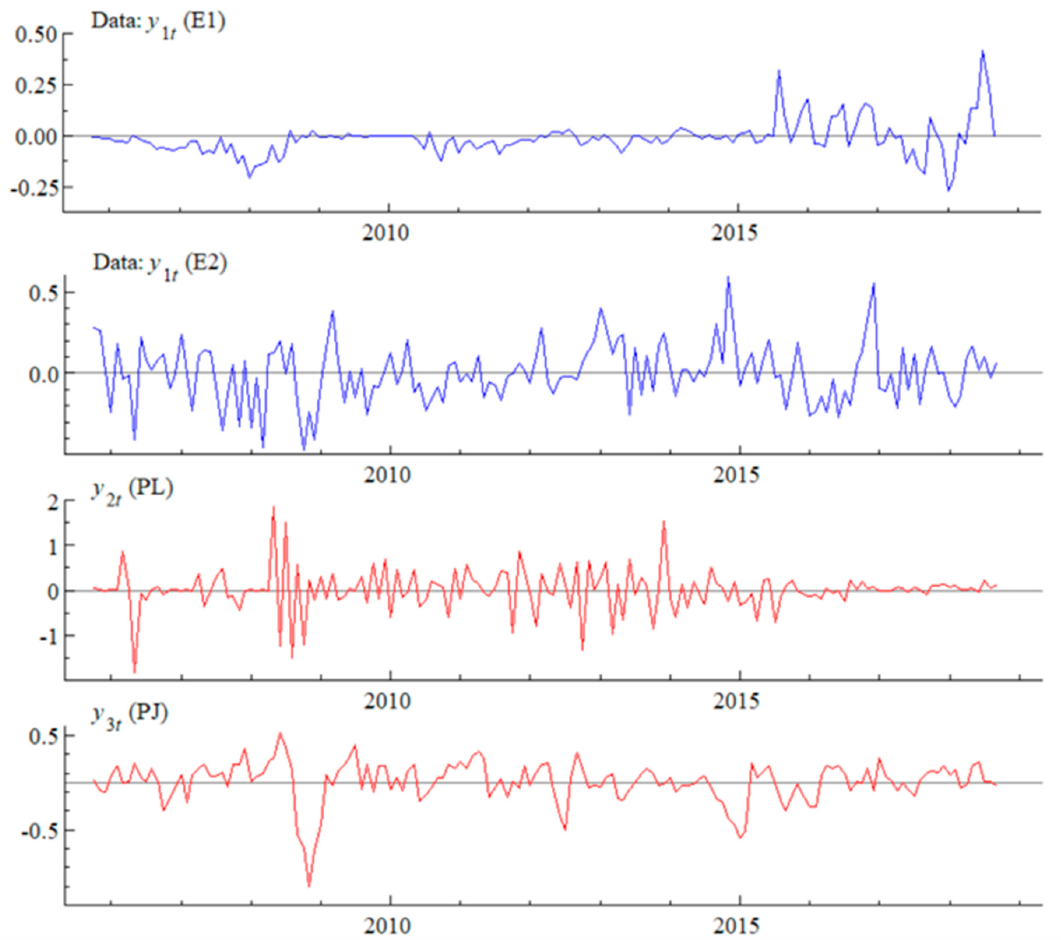
Figure 1. The plots of CNY (E1 t ), JPY (E2 t ), crude oil (PJ t ) and LNG import (PL t ) prices from August 2005 to September 2018.